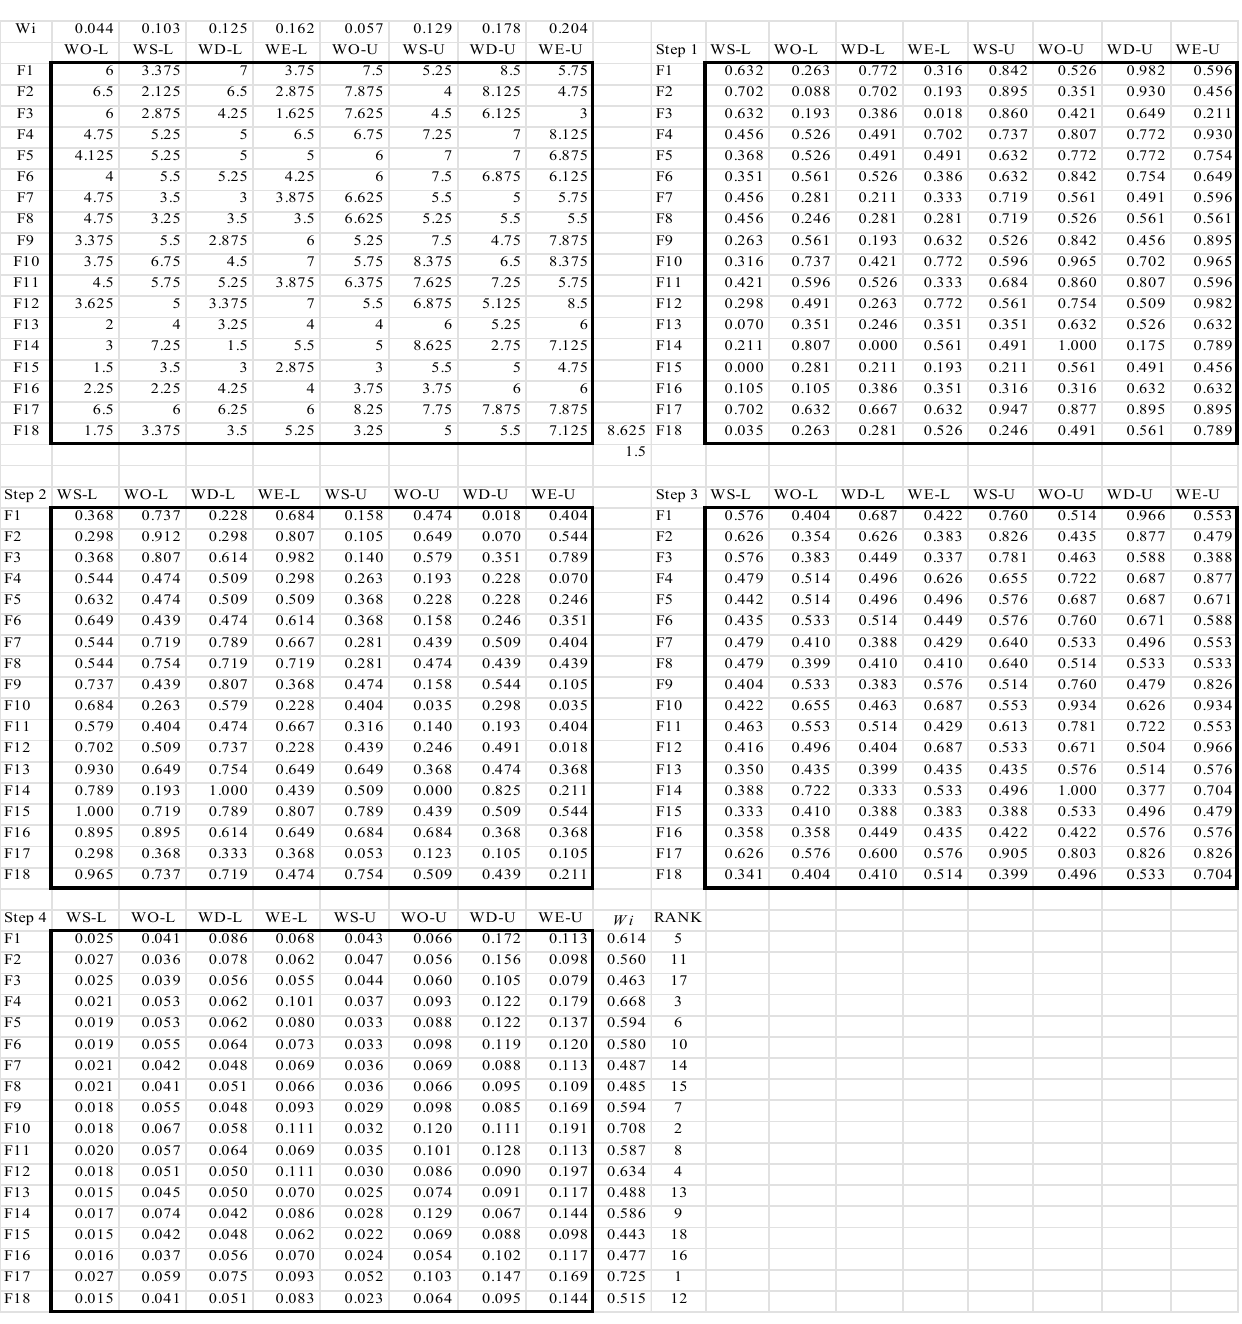
The Cardinal Grey Relational Grade [17]. The meaning of cardinal grey relational grade is taking quence, and the others are inspected sequences. Meantime, they have five kinds of grey relational grade, as shown below.